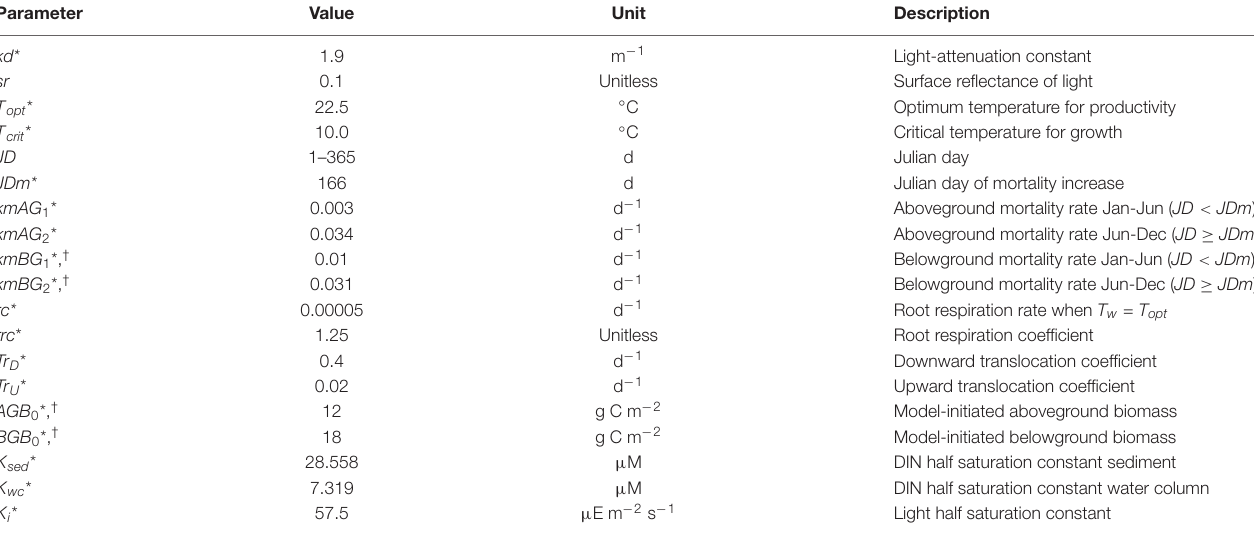
TABLE 2 | Biomass production model parameters and values for the biomass production model.